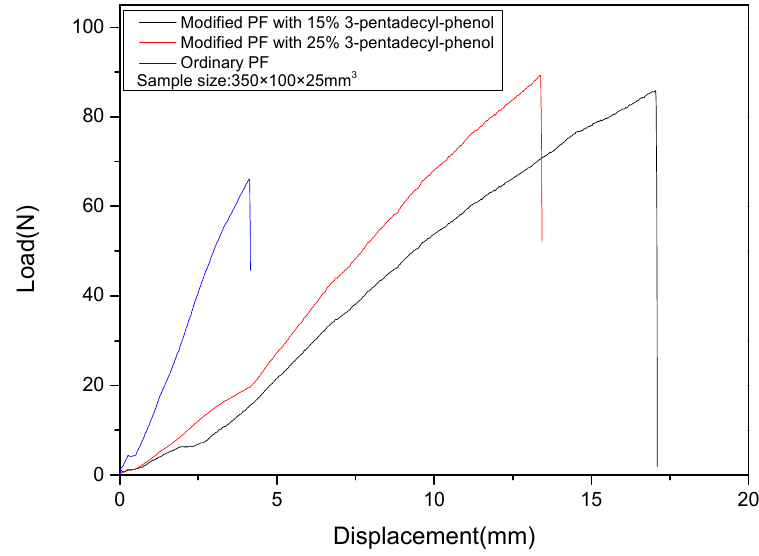
Figure 4. The bending characteristics of the phenolic foam: load-displacement curves.